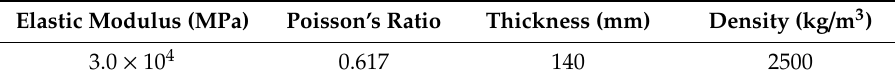
Figure 2. Layout of control points, mesh and initial guess shape of model 1: ( a ) Layout of control points and mesh, ( b ) Initial guess shape. Table 2. Material parameters and shell thickness.